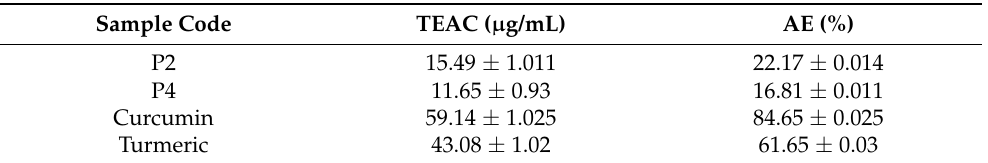
Table 3. The antioxidant activity parameters obtained for the P2 and P4 samples, curcumin, and turmeric